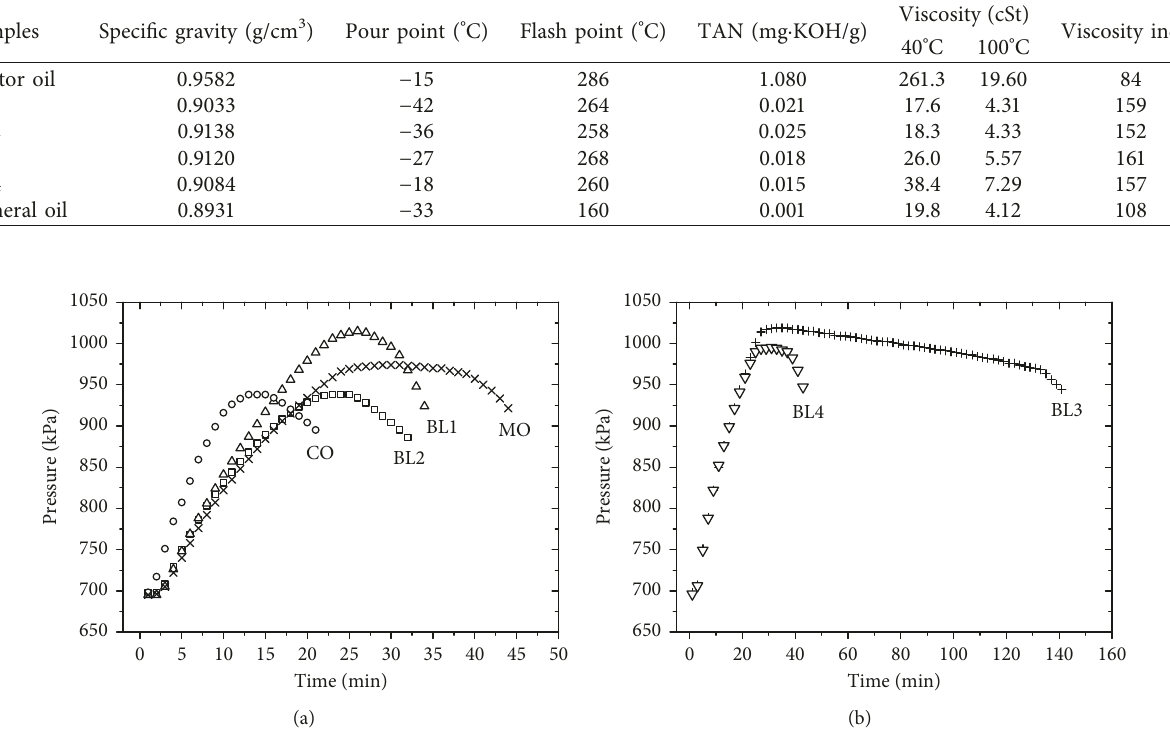
Figure 6: Pressure profiles for accelerated oxidation experiments at 140 ° C with samples. ◯ , CO; × , MO; ∆ , BL1; € , BL2; +, BL3; ▽ , BL4.